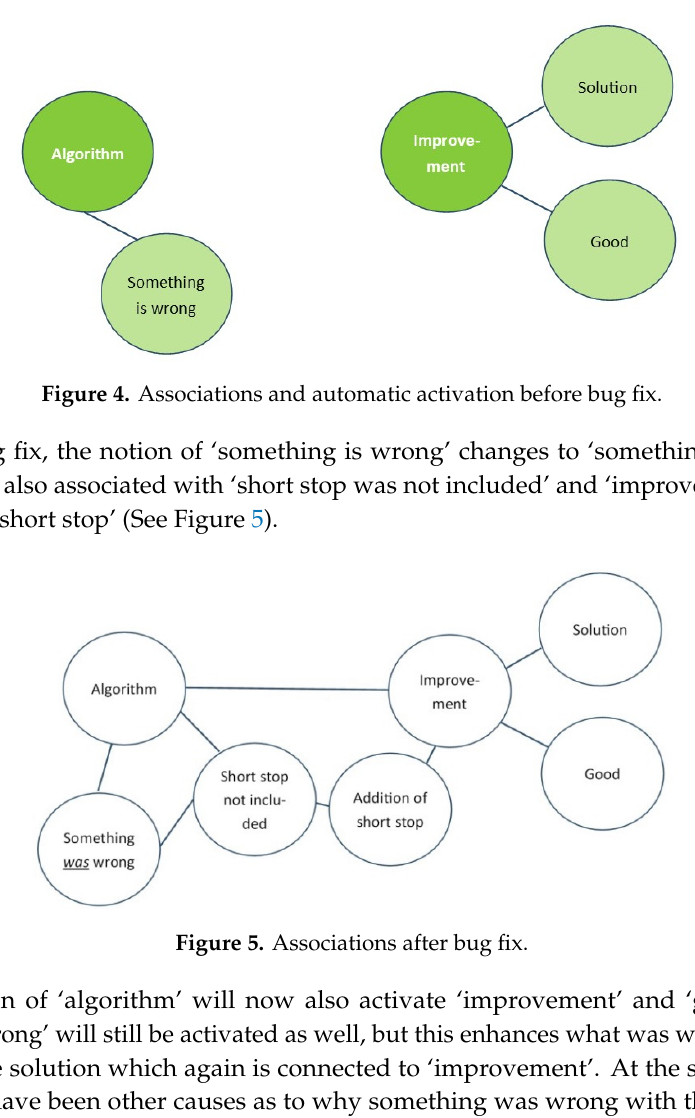
Figure 6. Associations and activation after bug fix.